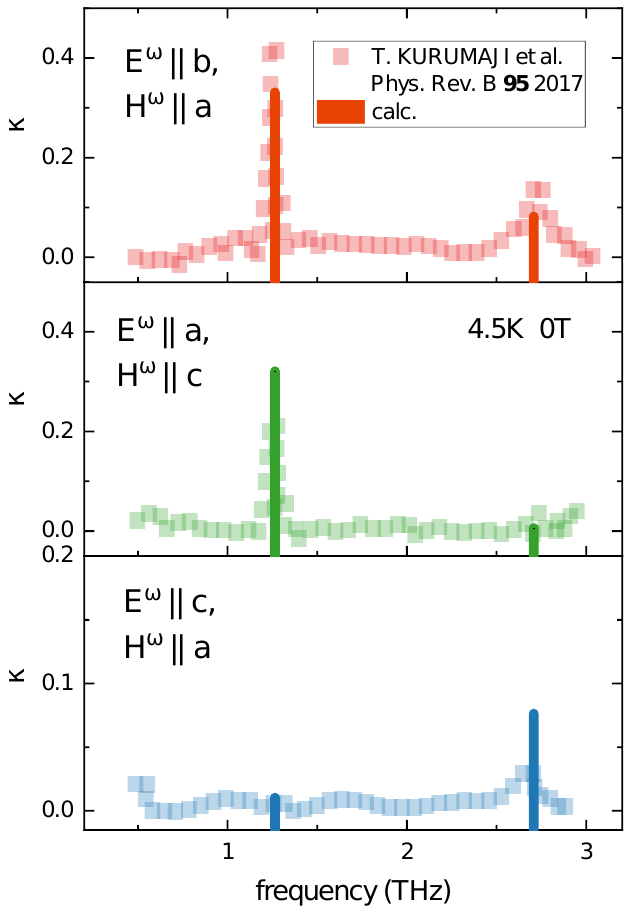
Figure 2. Calculated (vertical lines) and experimental (square symbols) [2] Fe 2 Mo 3 O 8 absorption spectra in the THz region for various incident light